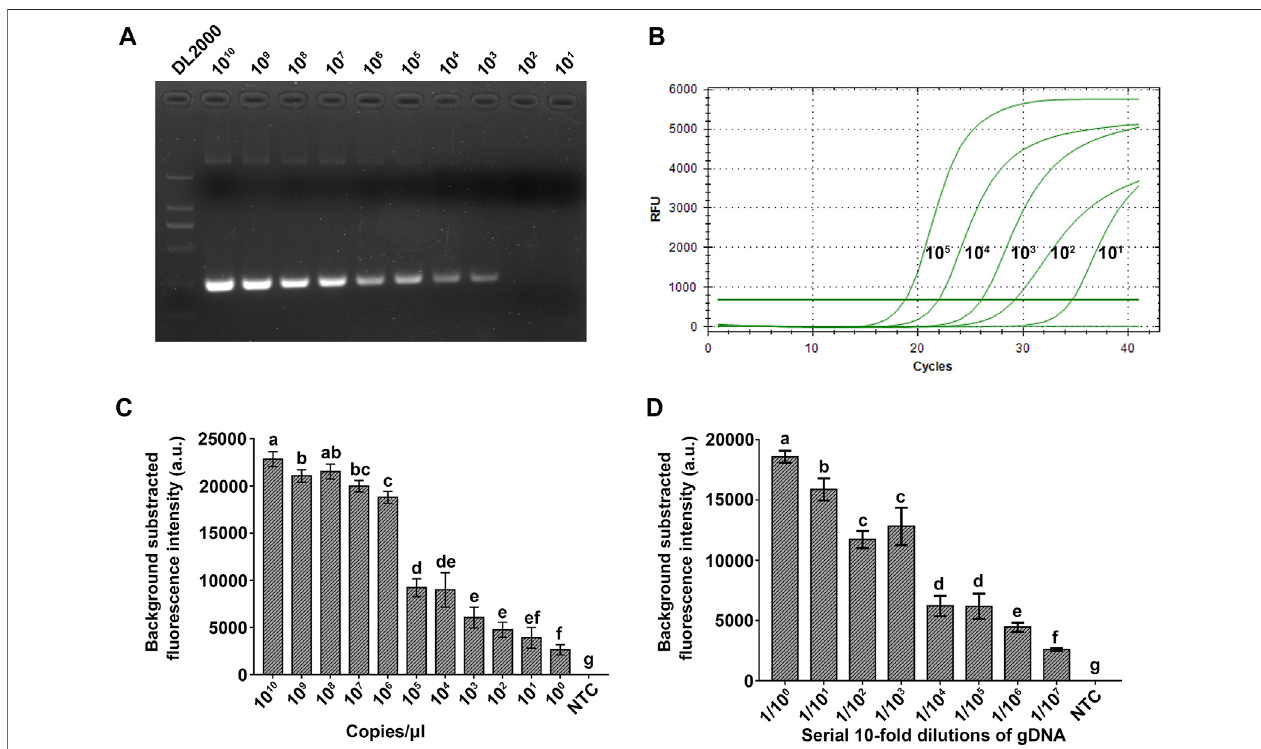
FIGURE 5 | Evaluation of the sensitivity of the RPA-Cas12a-Ab assay. (A) Sensitivity evaluation of PCR using a serial 10-fold dilution (10 10 − 1 copies/ μ l) of the pUC57-18S plasmid. (B) Sensitivity evaluation of qPCR using a serial 10-fold dilution (10 5 − 0 copies/ μ l) of the pUC57-18S plasmid. (C) Sensitivity evaluation of the RPA- Cas12a-Ab fl uorescence assay using a serial 10-fold dilution (10 10 − 1 copies/ μ l) of the pUC57-18S plasmid. (D) Sensitivity evaluation of the RPA-Cas12a-Ab fl uorescence assay using a serial 10-fold dilution (1 – 1/10 7 ) of single A. besseyi nematode genomic DNA. The initial gDNA of a single A. besseyi is about 9.6 ng/ μ l. The data are presented as mean ± SD ( n = 3). Copy numbers and serial dilution values that are signi fi cantly different from each other are labeled with different lowercase letters above each bar. NTC, no template